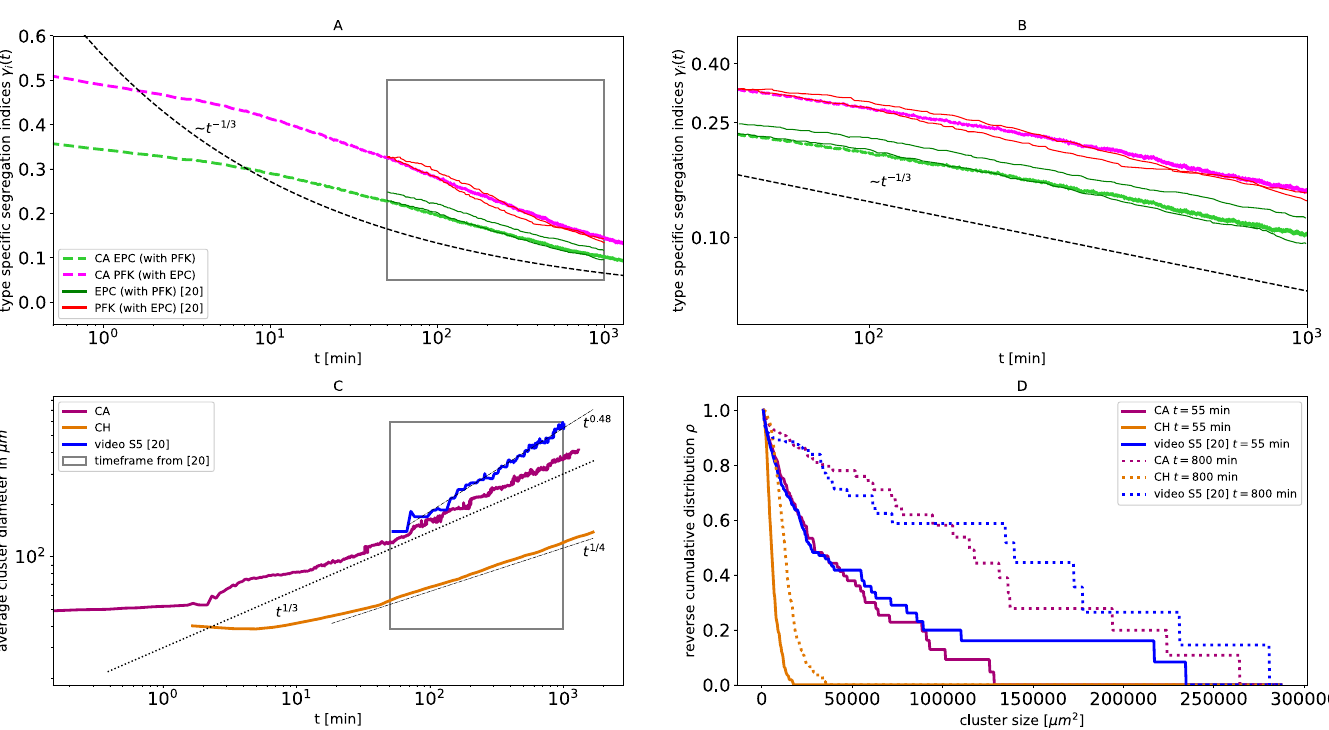
Fig 6. Example representation of the metrics segregation indices γ , average cluster diameter and cluster size distribution ρ with γ - ρ -fitted parameters for the i cellular automaton for the PFK and EPC experiment of Me´hes et al. [20]. Panels A and B are analogous to Fig 1, Panel C is analogous to Fig 5 and Panel D is analogous to Fig 4. The simulation used 140 2 cells with a cell type ratio of N PFK / N EPC = 41.2/58.8, the adhesion parameter ( β PFK-PFK , β EPC-PFK , β EPC-EPC ) = ( − 8.0, − 5.5, 0.0) and a time scale of migration τ PFK-EPC � 20.0 min.